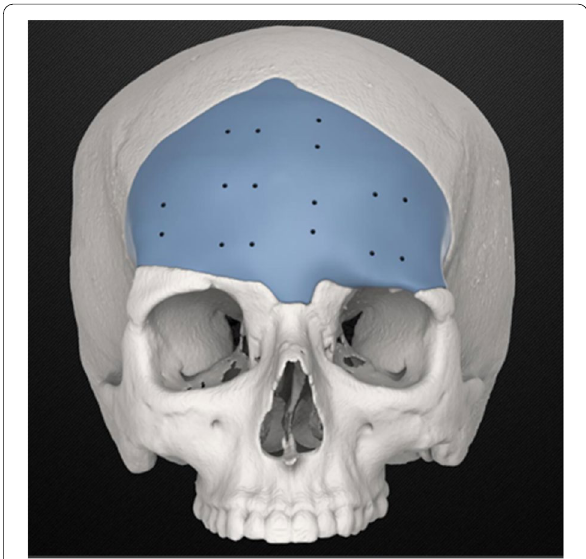
Fig. 1 Case 5 3D render, the implant was planned as one piece partial onlay and partial full thickness; the problem encountered was that the implant was a little too big for the void, probably because some fibrotic parts were not visible in the CT; in addition, the thickness of the implant was exactly the same as the actual calvarial bone, and this has led to an increased rate of impingement with the fibrotic tissue, reducing the available space on the intracranial side